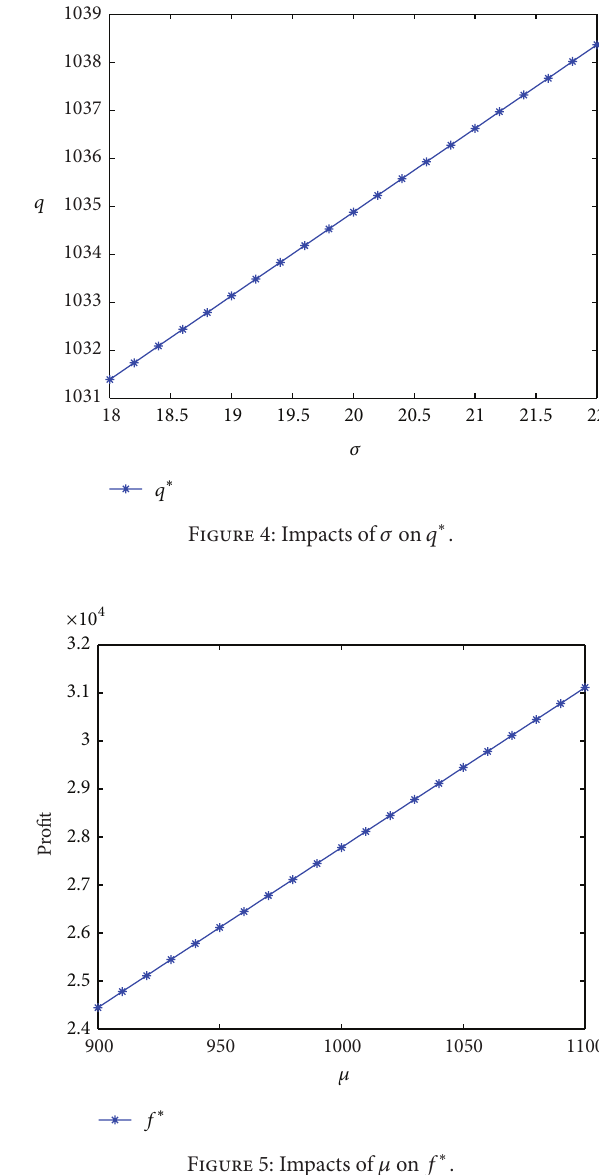
Figure 5: Impacts of 𝜇 on 𝑓 ∗